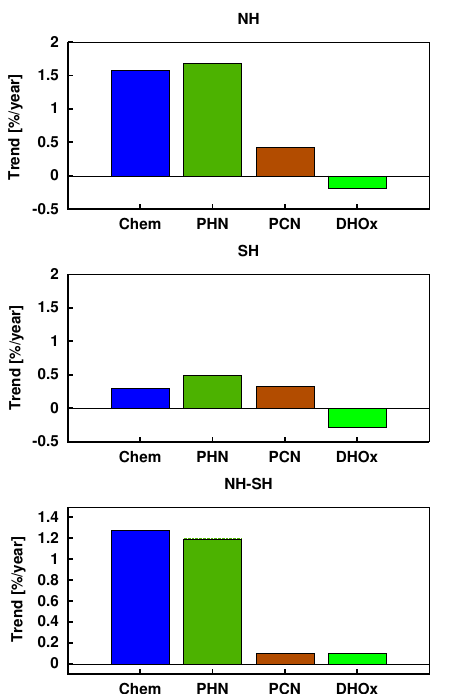
Fig. 11. Contributions to the chemically-induced ozone trends (blue bars) in the NH (top) and SH (middle) mid-latitudes, and the hemi- spheric difference (bottom), integrated between 250 and 300hPa in E39CA. Reaction cycles are the production via HO 2 + NO (“PHN”) and CH 3 O 2 + NO (PCN), and the HO x destruction cycle. The Chap- man production cycles and the NO x and ClO x destruction cycles are omitted since their contributions are close to zero.